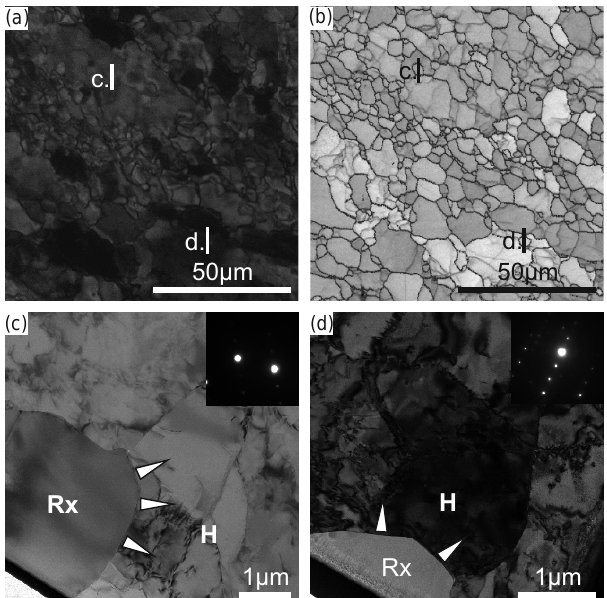
Figure 6. (a) Optical micrograph (crossed polarizer) showing the transition zone between coarse- and fine-grained ultramylonite. Panels (c) and (d) represent the locality of focused ion beam (FIB) foils. (b) Electron backscatter diffraction (EBSD) map showing the transition zone between coarse- and fine-grained ultramylonite. High-angle boundaries (>15 ◦ ) are plotted in blue. Panels (c) and (d) show the locality of FIB foils. Note that the foils represent a profile across fine-grained ultramylonitic grains adjacent to a coarse grain. (c) Dislocation-rich host ( H ) calcite and dislocation- free recrystallized ( R x ) grains. Bulging (migration) direction of re- crystallizing grain boundary shown by arrows. TEM bright field; g = 02 − 2 − 1. (d) Dislocation-free calcite grain (Rx) adjacent to coarser grains with a high density of free dislocations and dislo- cations arranged to low-angle grain boundaries. Bright field TEM; B ∼ [2 − 201] in host grain.